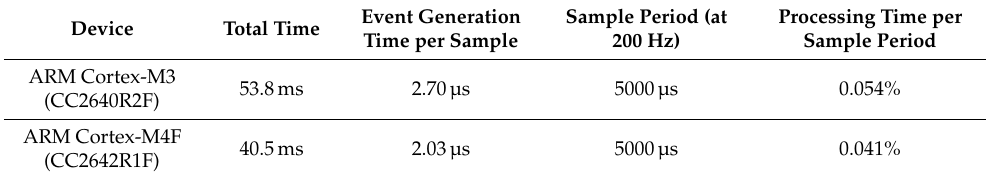
Table 5. Event generation time using ARM Cortex-M3 and Cortex-M4 MCUs processing 20,000 samples (100 s dataset). A total of 146 events generated.